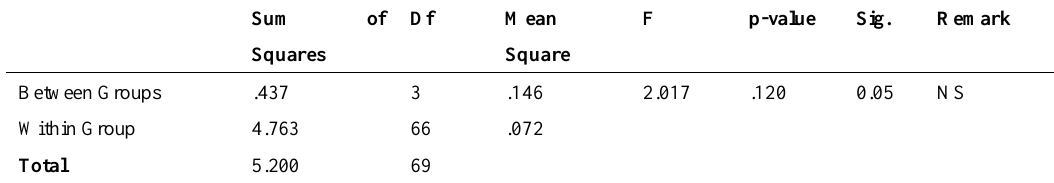
Table 9: Analysis of Variance (ANOVA) of grand mean responses of the respondents on consequences of inflation on the people of Enugu State based on their ages